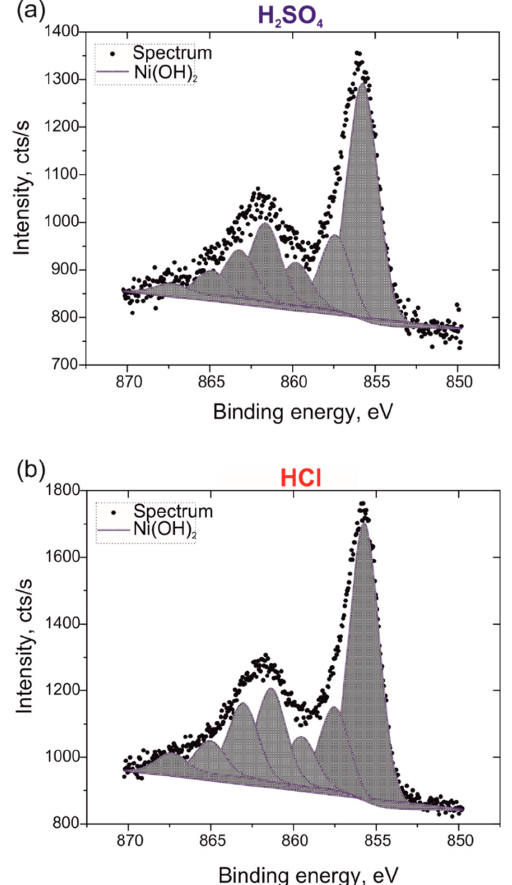
Figure 6. High-resolution deconvoluted XPS spectra of Ni 2p 3/2 for hybrid PPy-Ni(OH) 2 nanowires deposited in the presence of H 2 SO 4 ( a ) and HCl ( b ) in the Watts-type electrolyte containing 0.15 M Py + 0.10 M LiClO 2 + 0.10 M Na 2 CO 3 .